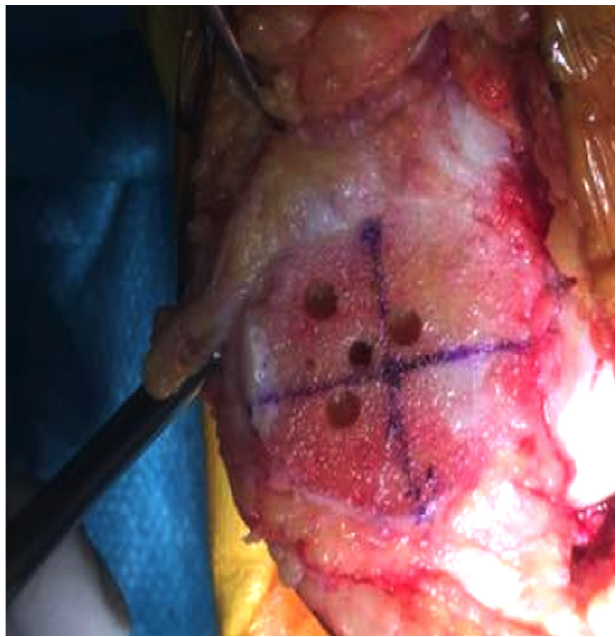
Figure 8. Drill guide is positioned over the OCPP and pegs are drilled.